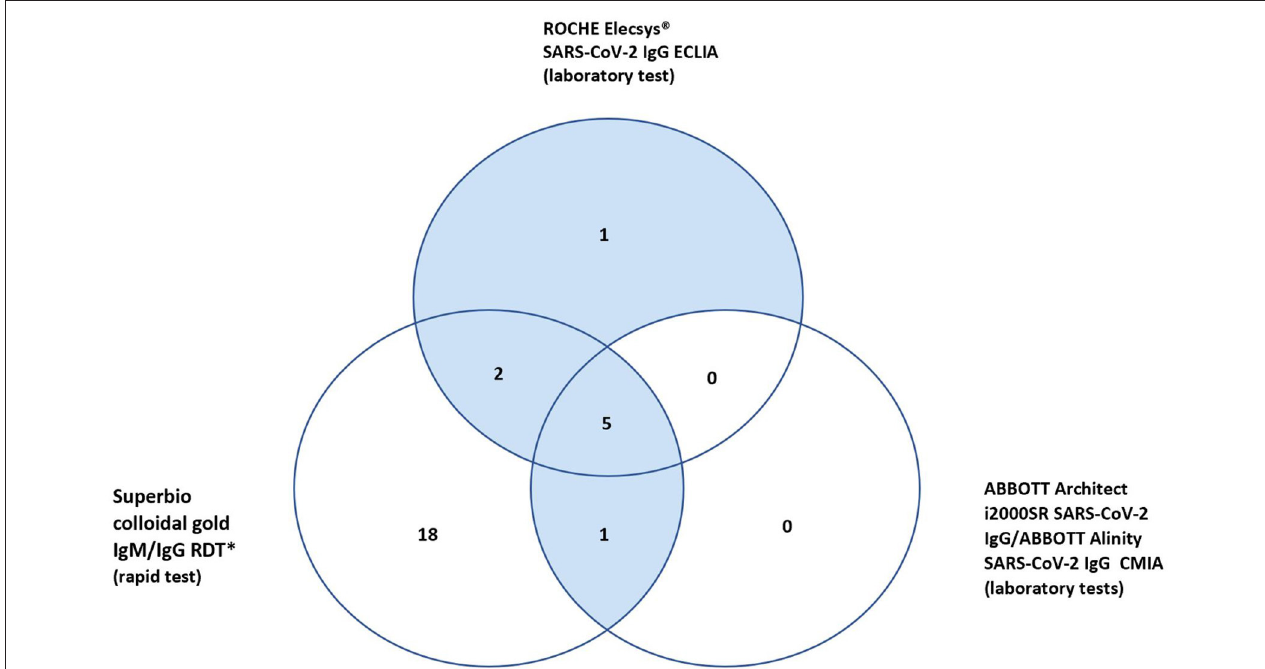
FIGURE 2 | Venn diagram of positive IgG